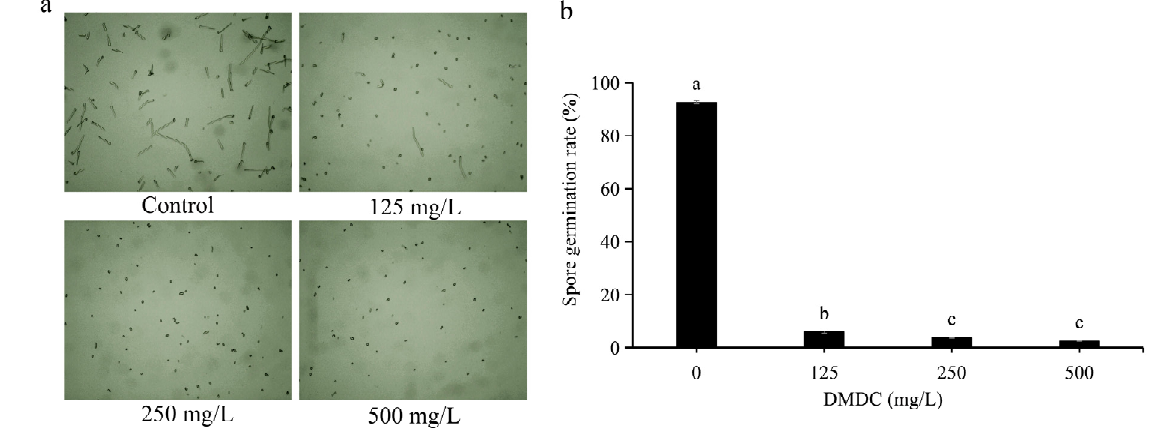
Figure 3. G. citri-aurantii was treated with DMDC at concentrations of 0, 125, 250, and 500 mg/L, and germination was observed after 8 h. ( a ) Spore germination was observed under a light microscope. ( b ) Spore germination rate after treatment with different concentrations of DMDC. The data represent the mean ± standard deviation (SD). Different letters on each column represent significant differences ( p < 0.05 ) according to Duncan’s test.